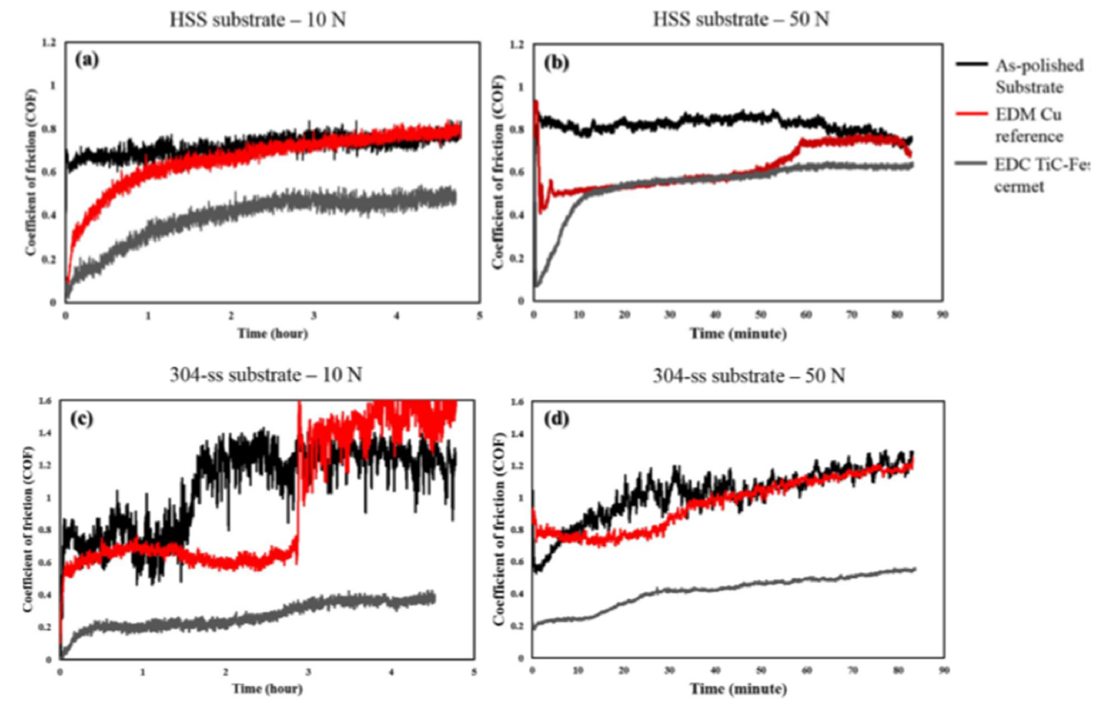
Figure 21. A comparison of the time-dependent coefficient of friction of the as-polished substrate and the coated and EDMed samples at various loads: ( a , b ) HSS substrate and ( c , d ) 304 SS substrate [130]. (With kind permission from Elsevier).